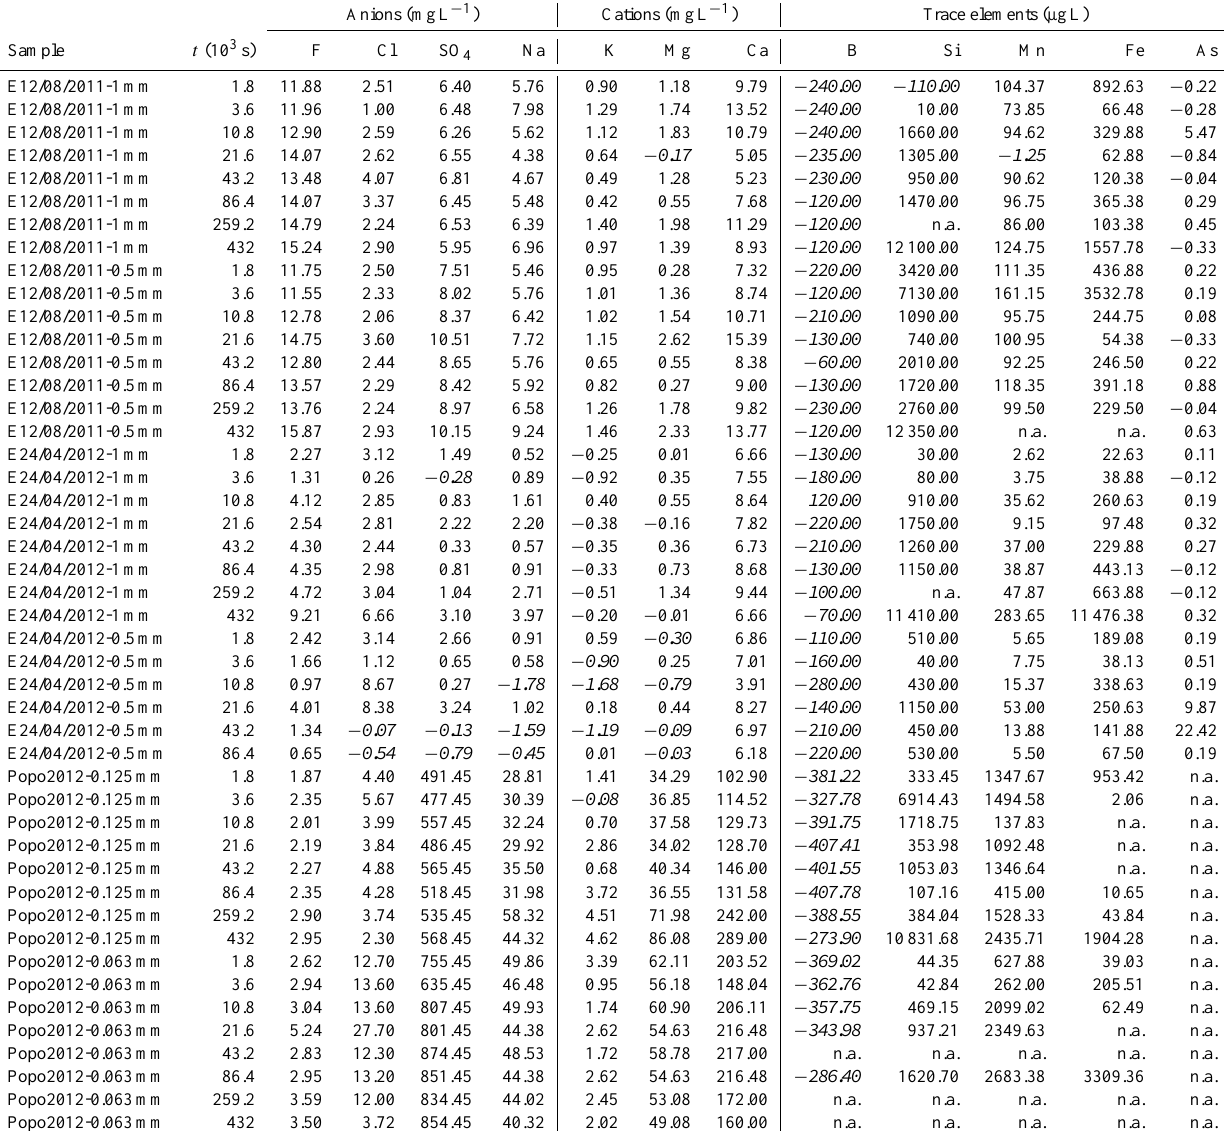
Table 3. Net release of leachates in lake water for the Etna 2011, Etna 2012, and Popocatépetl samples with different grain sizes and various stirring times. Italics indicate the negative release of elements in lake water. b.d.l. denotes values below detection limit; n.a. denotes values not